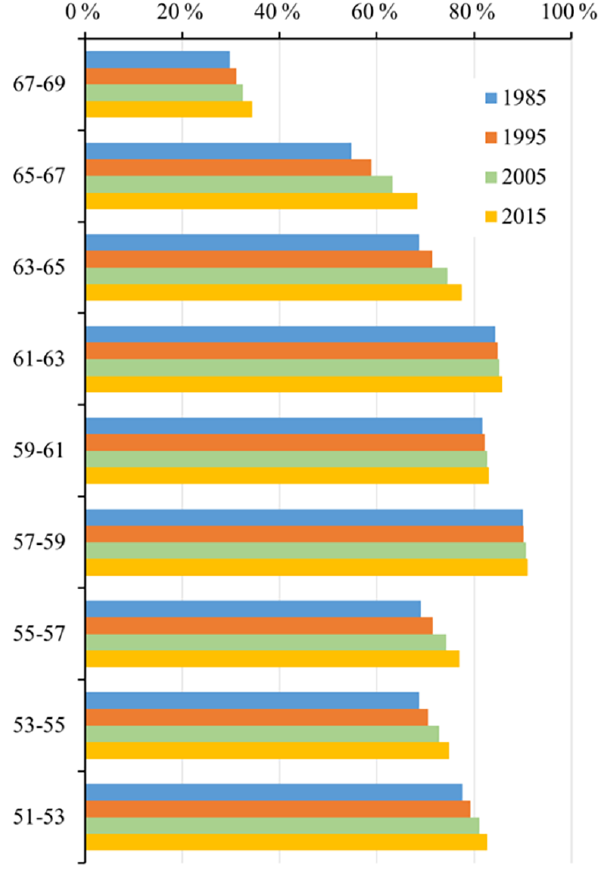
Figure 3. Boreal forest land cover within different latitude zones at four